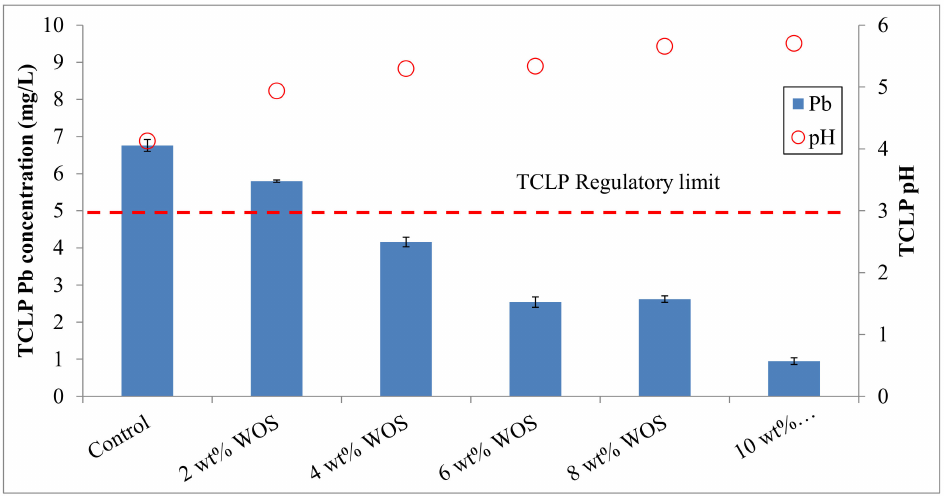
Figure 1. TCLP Pb concentrations for the control sample and waste oyster shells (WOS)-treated